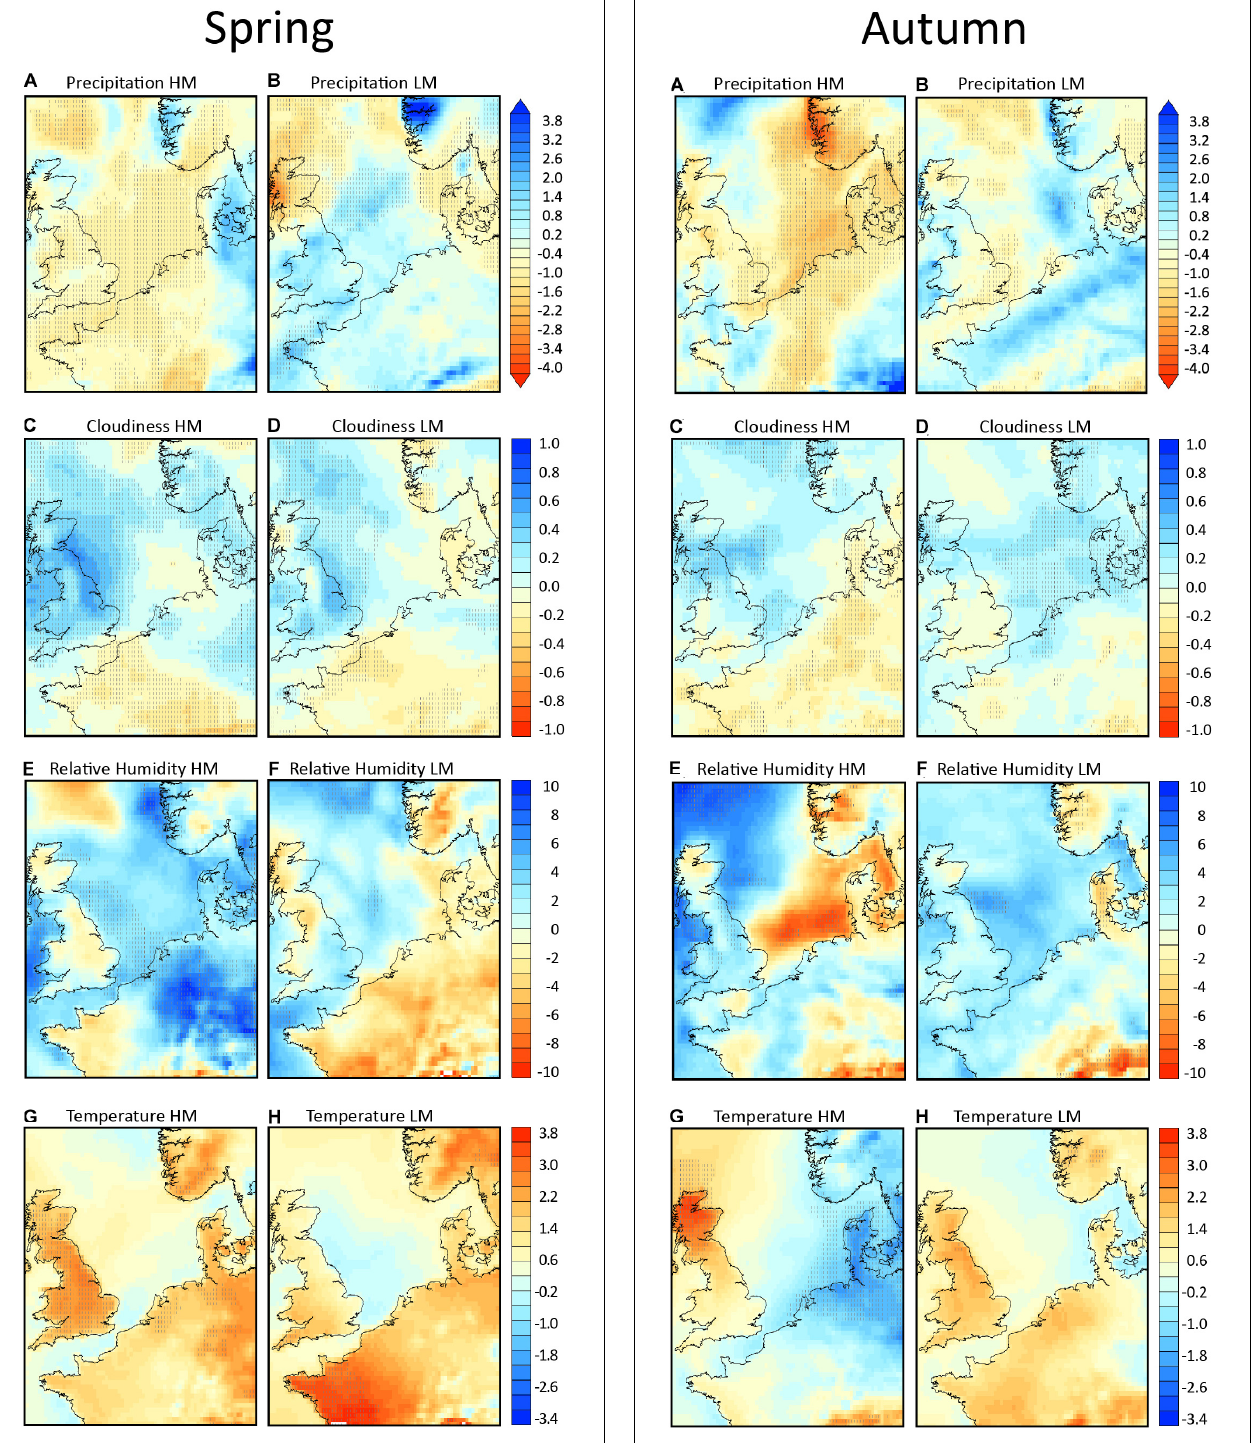
Frontiers in Ecology and Evolution |